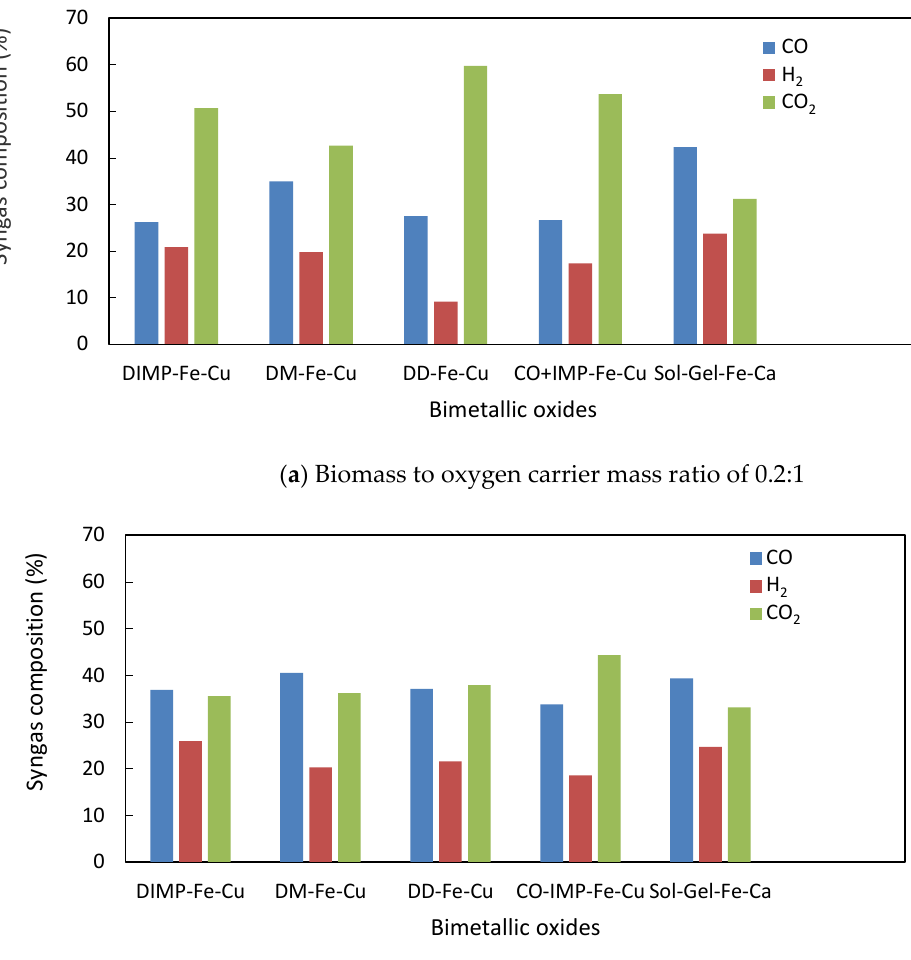
Figure 7. The compositions of syngas produced by the gasification of biomass with Fe-Cu and Fe-Ca oxides at various biomass to oxygen carrier mass ratios at 800 °C, ( a ) and ( b ). (DIMP: Dry impregnation, DM: Direct mixing, DD: Direct decomposition, CO+IMP: Coprecipitation + Impregnation)